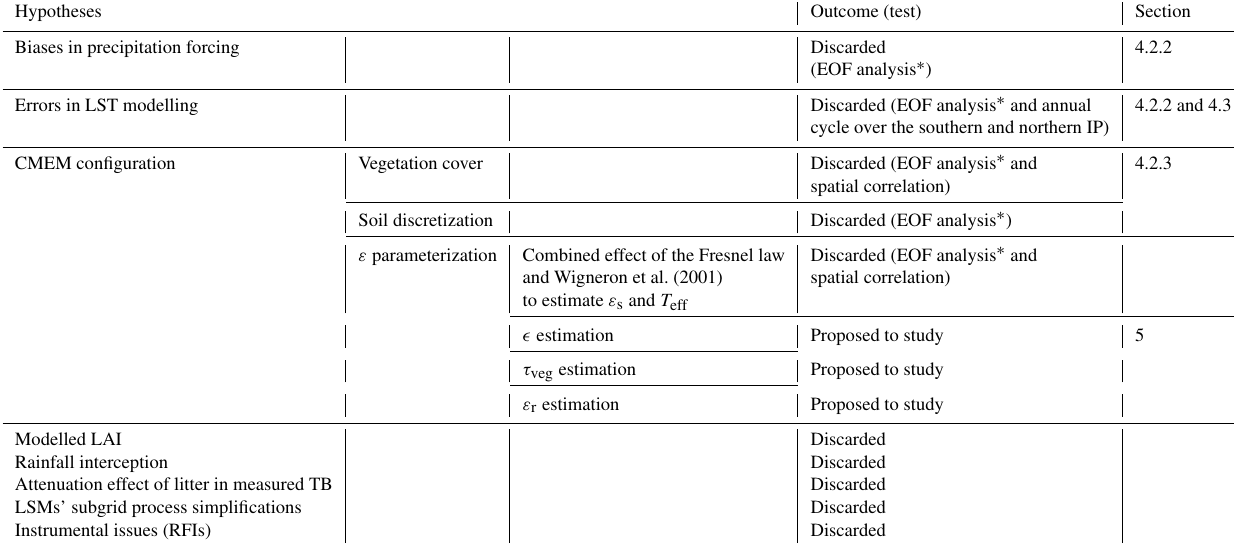
Table 6. Possible explanations studied and proposed to analyse the dominant mode of the error between measured and modelled TBs. The paper’s section where these are analysed has been included.